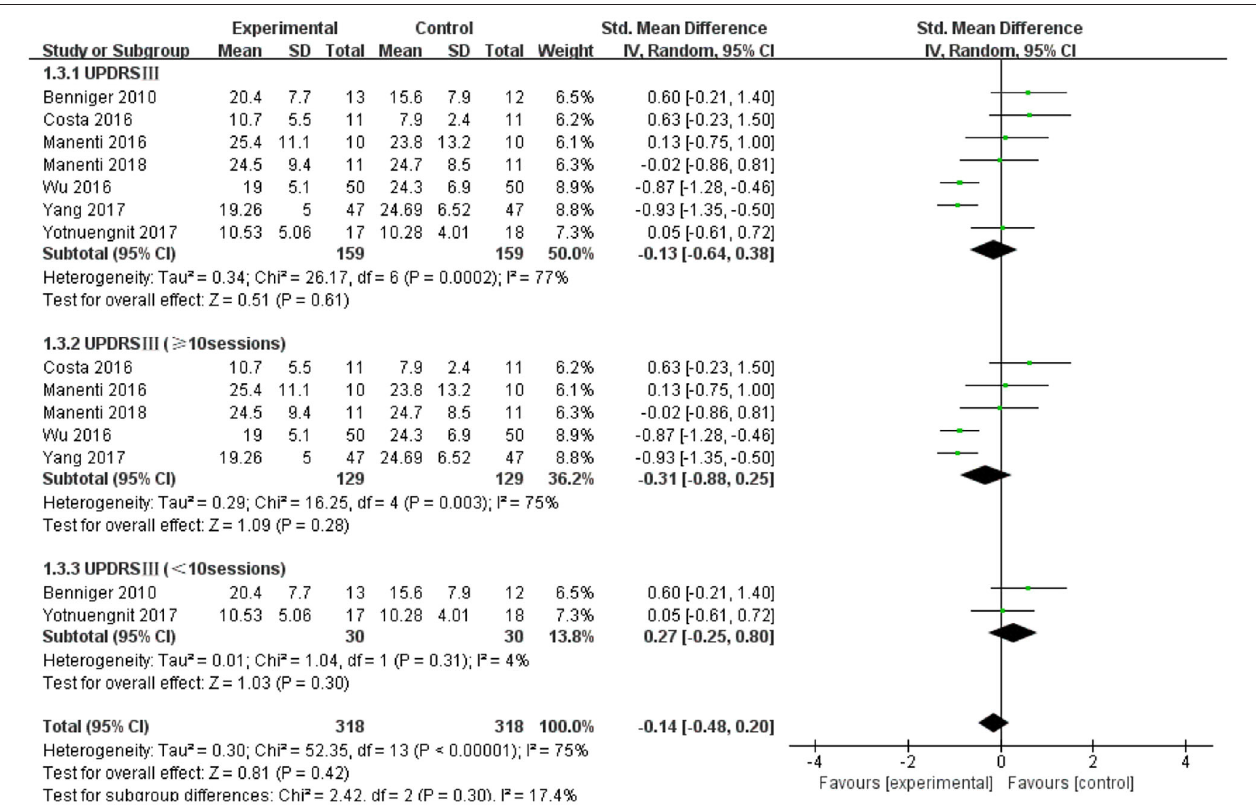
FIGURE 6 | Forest plot of UPDRS III according to the subgroups of tDCS session. CI, confidence intervals; SD, standard deviation; tDCS, transcranial direct current stimulation; UPDRS, Unified Parkinson’s Disease Rating Scale.